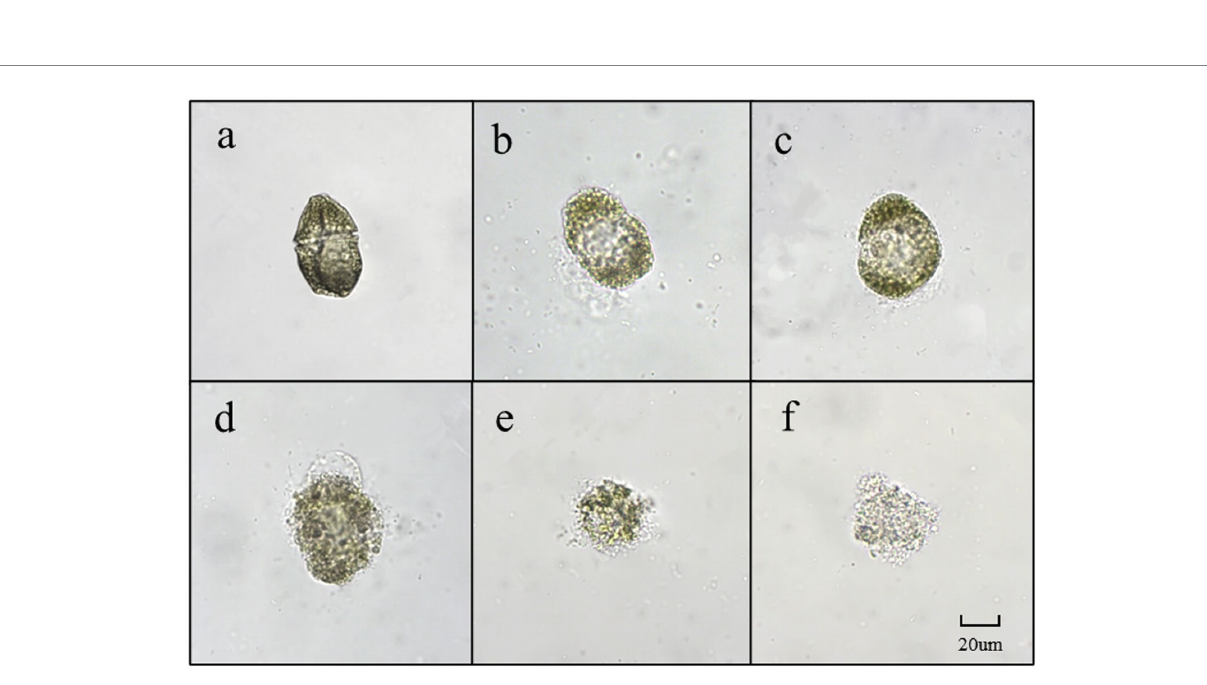
FIGURE 7 The main forms of algae in the algae dissolution process of G. catenatum under the influence of Pseudomonas sp. Ps3 sterile fermentation broth ( A–F represent different stages of dissolution process,